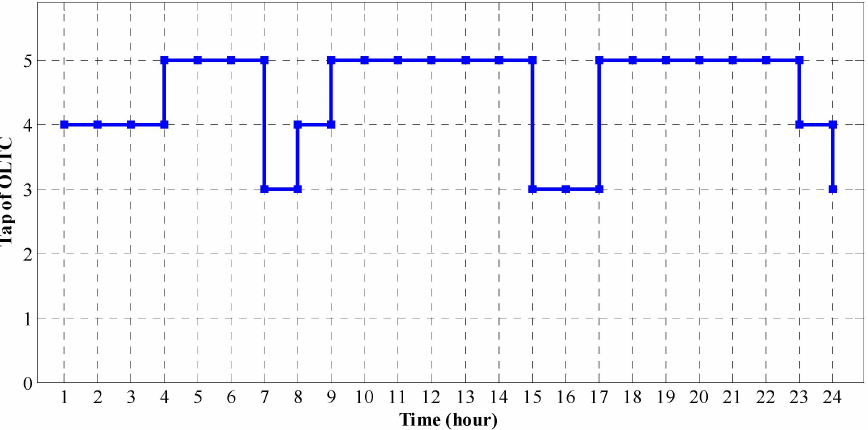
Figure 10. Optimal tap positions of OLTC for day-ahead in Scenario 1.